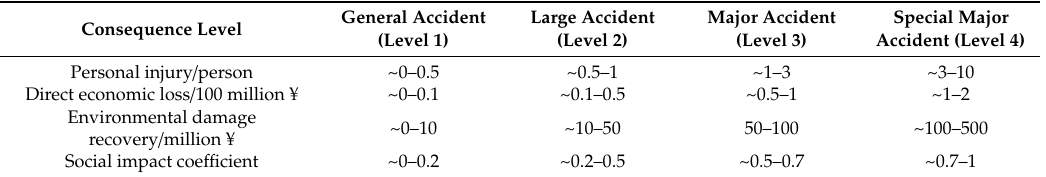
Table 9. Standard for the value of leakage consequences of heavy oil gathering